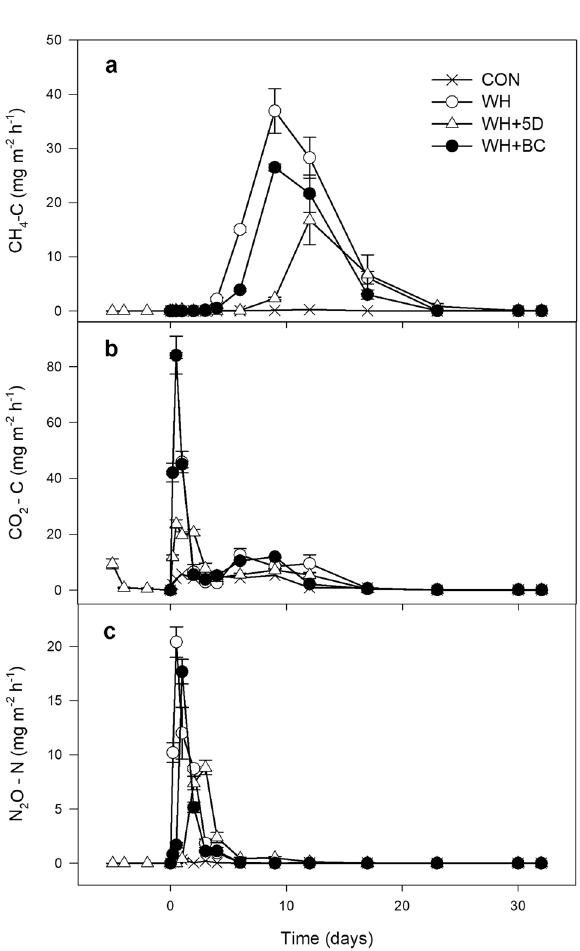
Figure 6. Dynamics of CH 4 , CO 2 and N 2 O emissions during BSD treatment period. CON: soil without any amendments; WH: soil amended with wheat straw; WH + 5D: soil amended with wheat straw 5 days before the BSD treatment; WH + BC: soil amended with wheat straw and